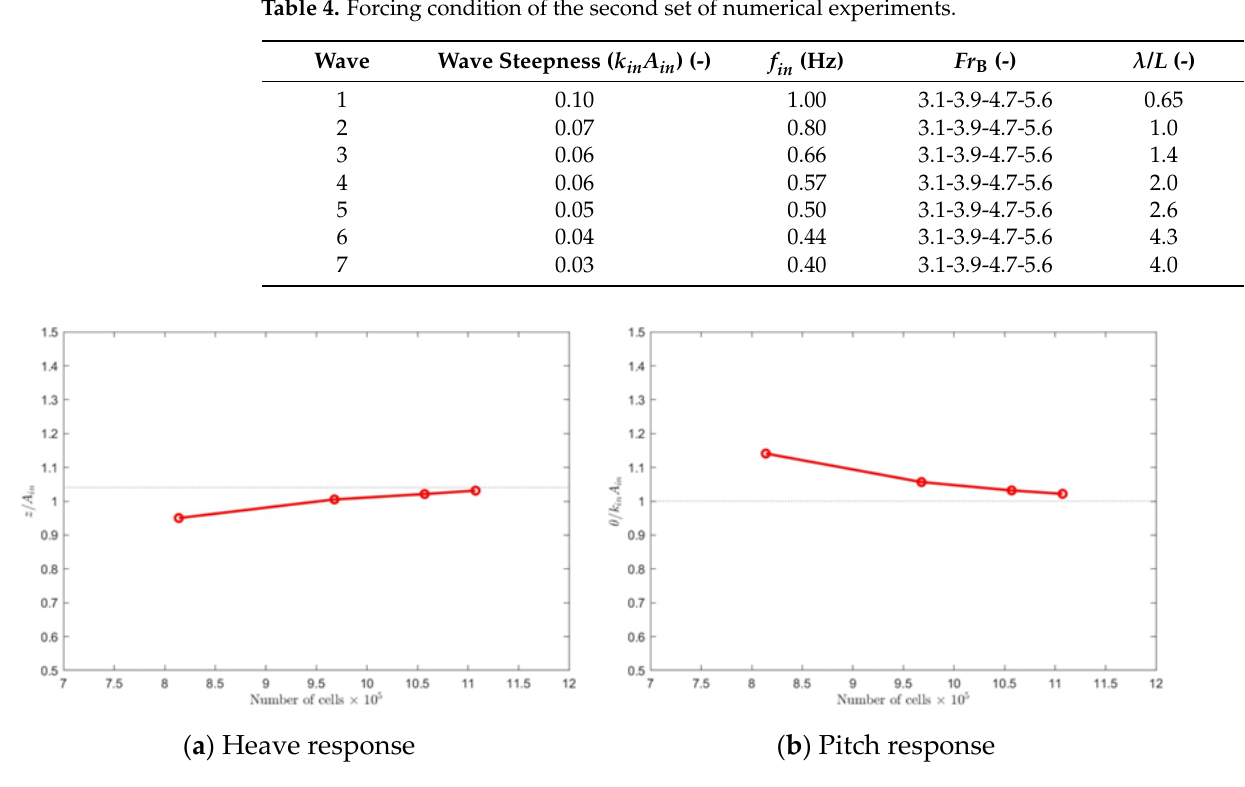
Figure 4. A mesh independence study is performed to find the optimum grid size. The left and right panels show the data corresponding to the heave and pitch responses. The results correspond to the heave and pitch motions of Model B. The wavelength is 2 L , and the Froude number is 4.7. Also, the uncertainty analysis of the grid is presented in Table 5. Here, R G is the grid refinement ratio. Furthermore, P G is the estimated order of accuracy. GCI refers to the